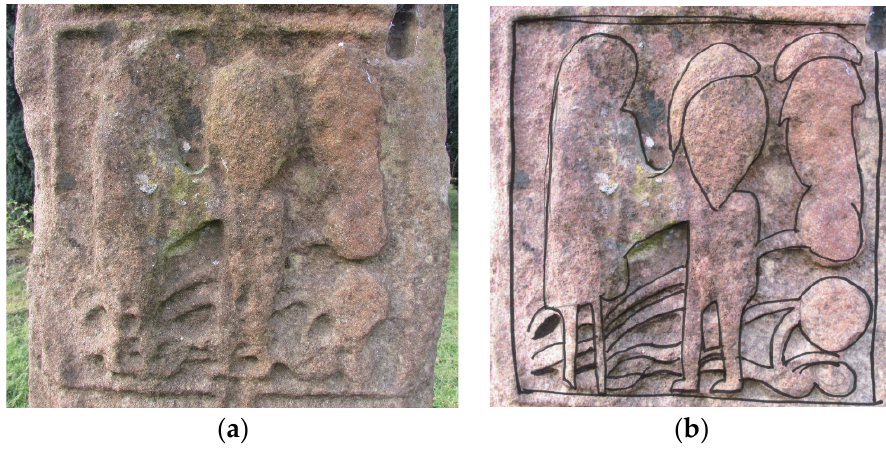
Figure 2 . ( a , b ). Baptism of Christ, E2, Camus cross ‐ shaft. Ninth century. Camus ‐ Macosquin Ceme ‐ Figure 2. ( a , b ). Baptism of Christ, E2, Camus cross-shaft. Ninth century. Camus-Macosquin Cemetery, tery, Co. Londonderry. Photograph: Megan Henvey; Interpretive Sketch: Megan Henvey. Co. Londonderry. Photograph: Megan Henvey; Interpretive Sketch: Megan